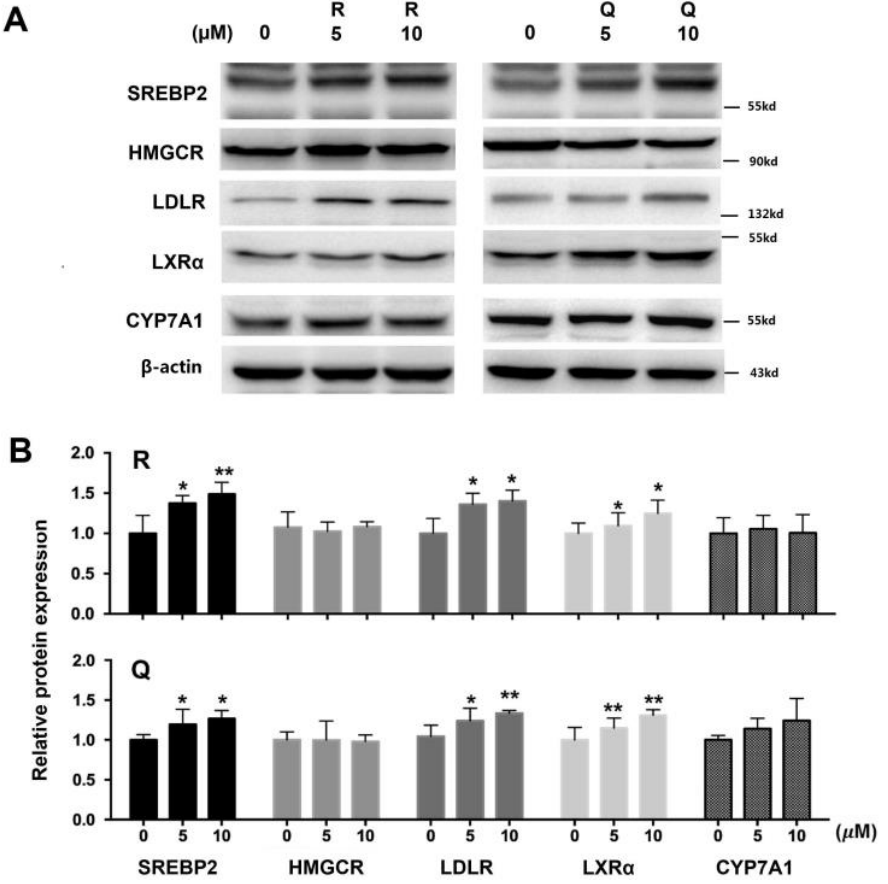
Figure 4. Effects of rutin (R) and quercetin (Q) on protein mass of SREBP2, HMG-CoA R, LDLR, LXR α , and CYP7A1 in HepG2 cells treated with 5 and 10 µM of R and Q for 24 h. ( A ) The total protein was extracted and subjected to Western blot analyses. ( B ) The relative band intensity was quantified and normalized with β -actin. Data represent the means ± standard deviations (n = 3). ** p < 0.01 or * p < 0.05 compared with the vehicle group.